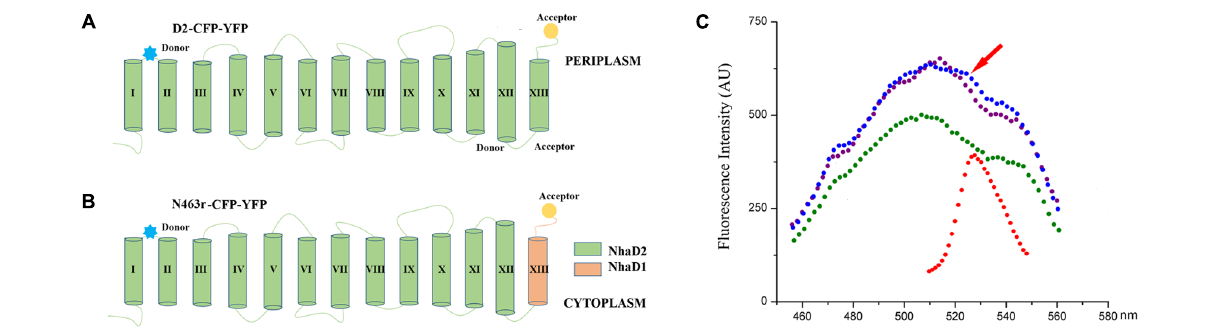
FIGURE 8 | Schematic representation and fluorescence spectra of cell suspensions containing N39 fusions for FRET analysis. (A) NhaD2 fusion protein with CFP fused at site 39 and YFP at the C terminus. (B) N463r fusion protein with CFP fused at site 39 and YFP at the C terminus. (C) Fluorescence spectra of CFP and YFP constructs. Fluorescence emissions upon excitation by 433 nm for CFP or 473 nm for YFP were measured in the cells that resuspending in Tricine-KOH buffer (pH 8.5). Fluorescence emission upon 473 nm excitation of D2-CFP-YFP was recorded as red; fluorescence emission of D2-CFP fusion cells that excited by 433 nm was recorded as green; fluorescence emission upon 433 nm excitation of D2-CFP-YFP was presented as blue; and fluorescence emission upon 433 nm excitation of N463r-CFP-YFP was presented as